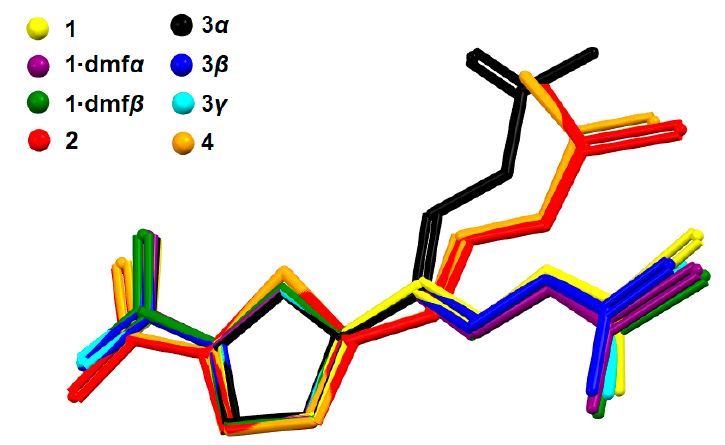
Figure 2. The molecular overlay of the studied compounds. The five-membered rings were arranged to provide the shortest distances between their constituent atoms.